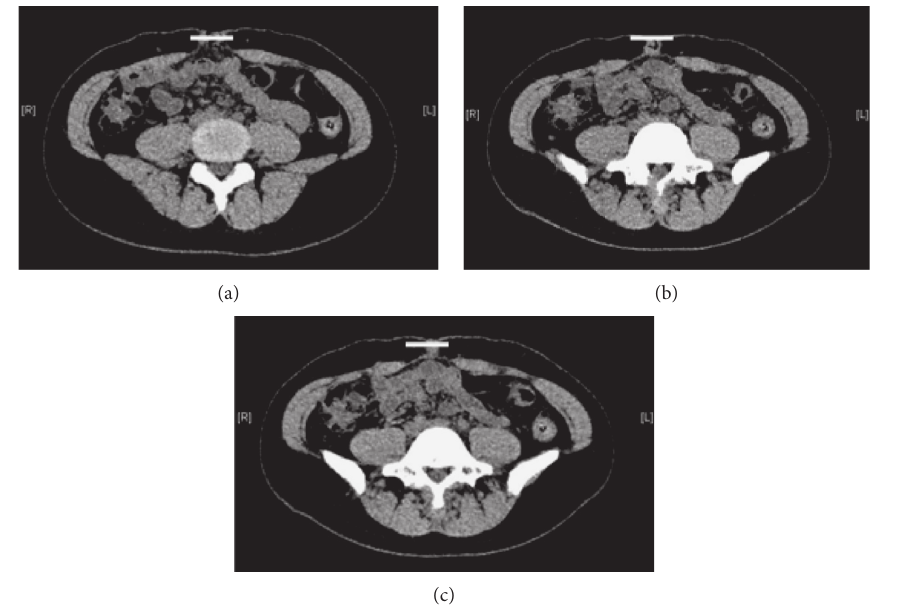
Figure 2: Preoperative abdominal computed tomography: (a) 3cm above the superior border of the umbilicus; (b) center of the umbilicus; (c) 2cm below the inferior border of the umbilicus. The inter-rectus distance is indicated by a white